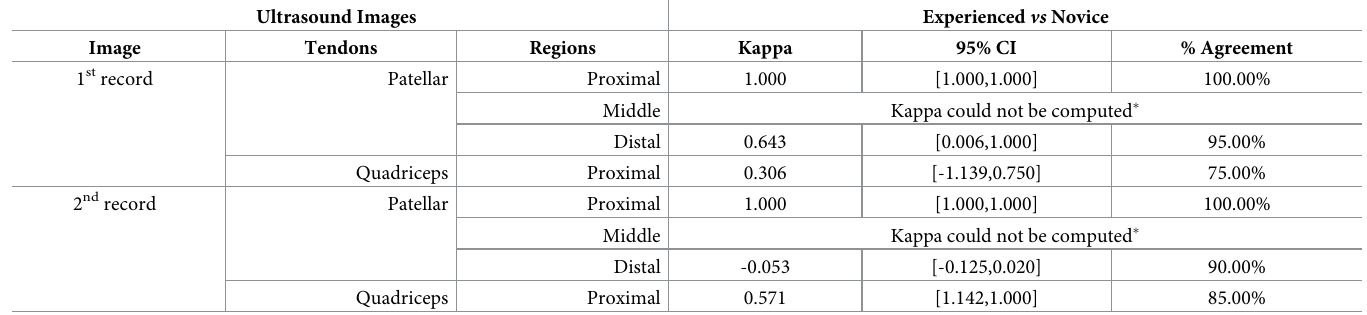
Table 2. Agreement between the quality of records acquired by two independent